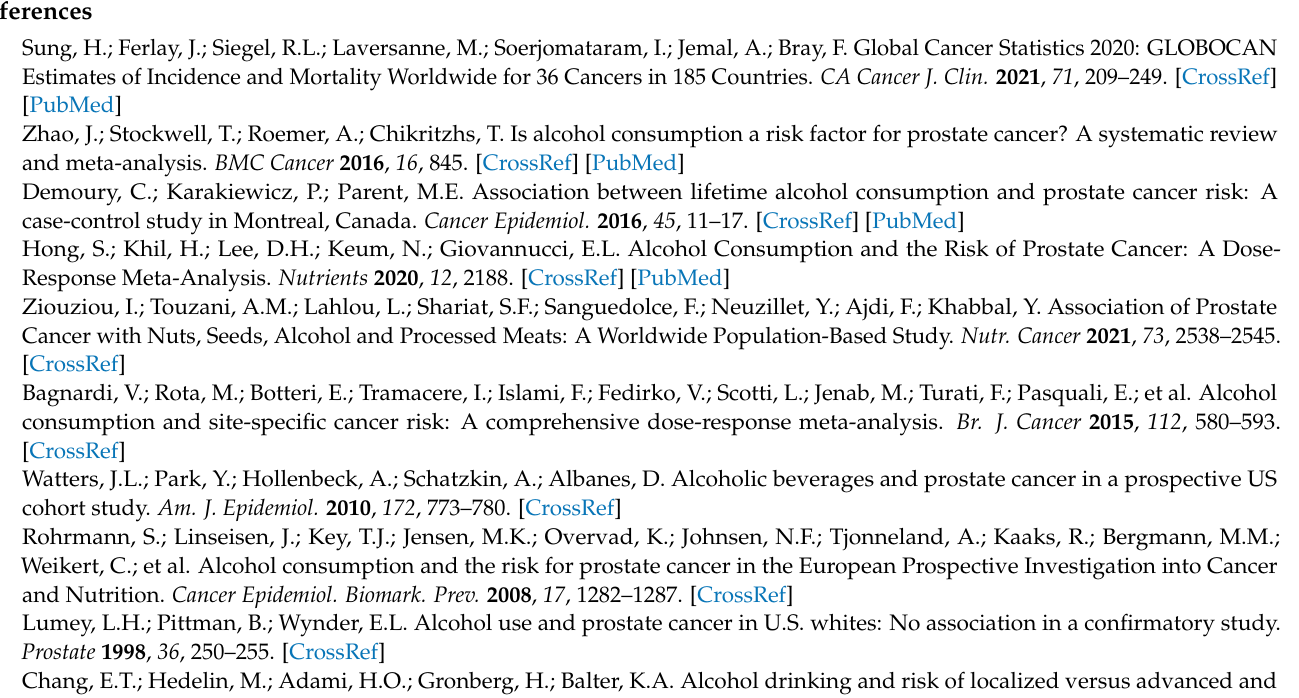
Table S1: Summary of prostate cancer (PCa) status and related information by study sites, Table S2: Prostate cancer risk status and other selected factors associated with intake of total alcohol and specific alcoholic beverage types, Table S3: Prostate cancer (PCa) aggressiveness status and other selected factors associated with intake of total alcohol and specific alcoholic beverage types for PCa